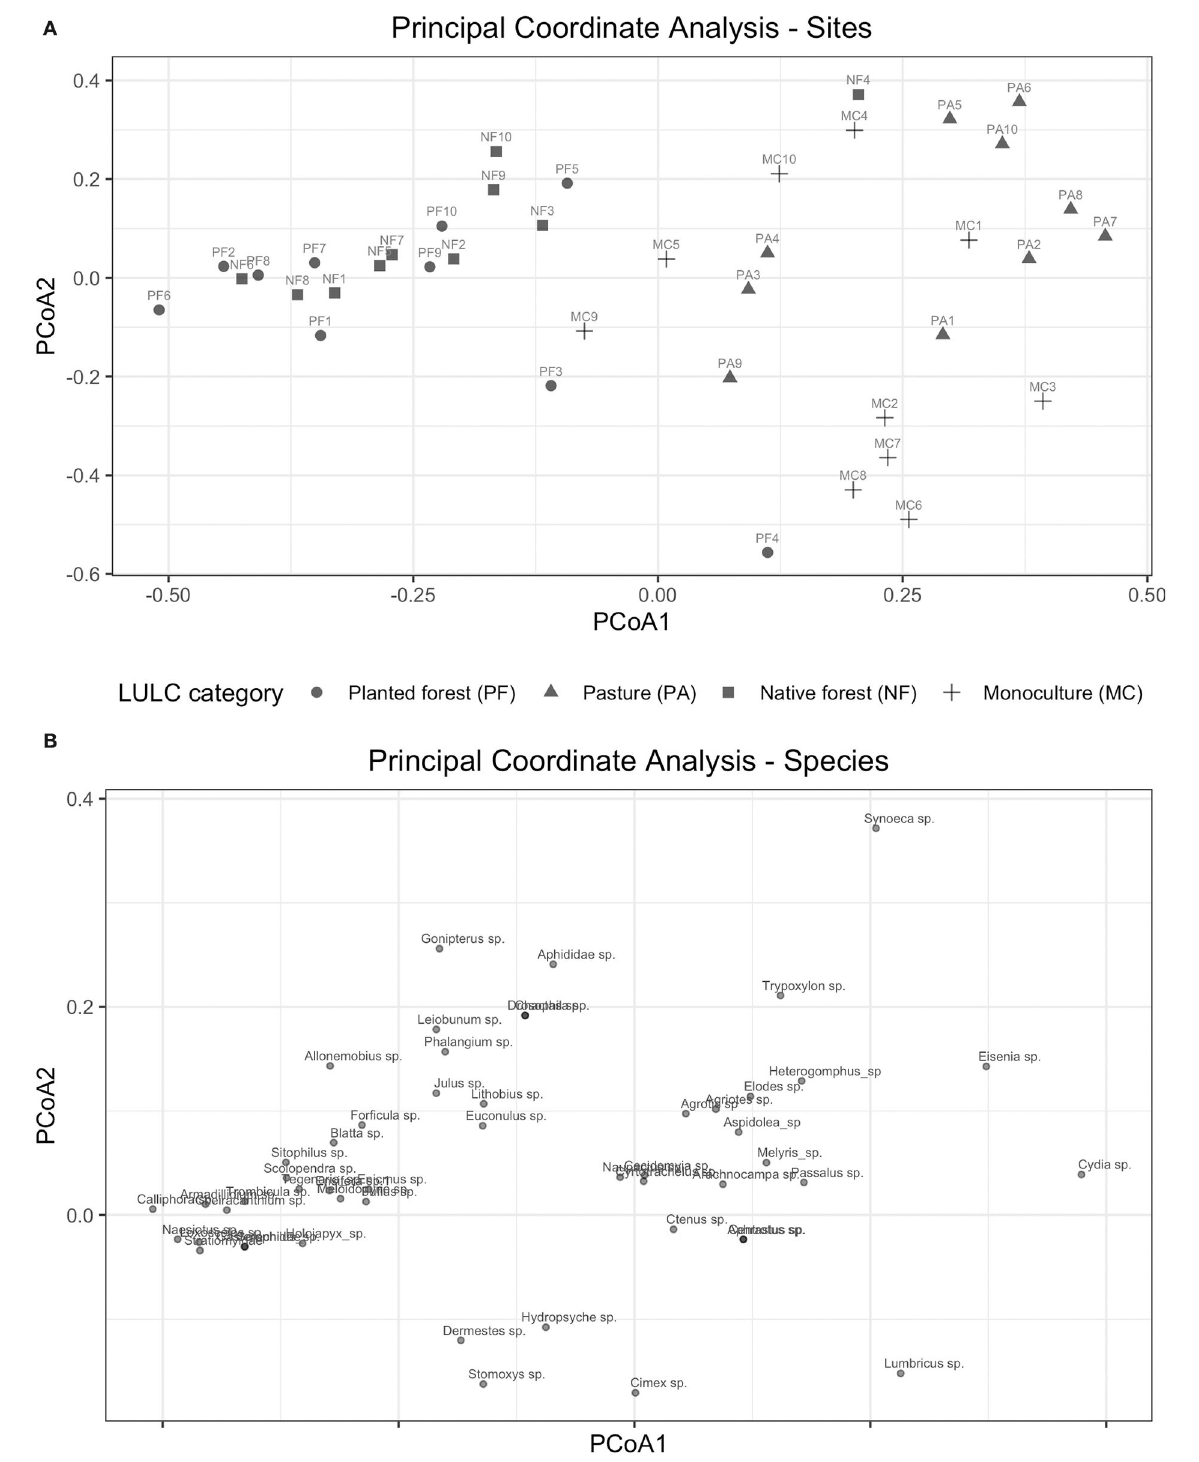
FIGURE4 Beta diversity analysis of soil macroinvertebrates at genus level by land use category. (A) Principal coordinate analysis (PCoA) representing sites. (B) Principal coordinate analysis (PCoA) representing Bray–Curtis dissimilarity matrix at genus